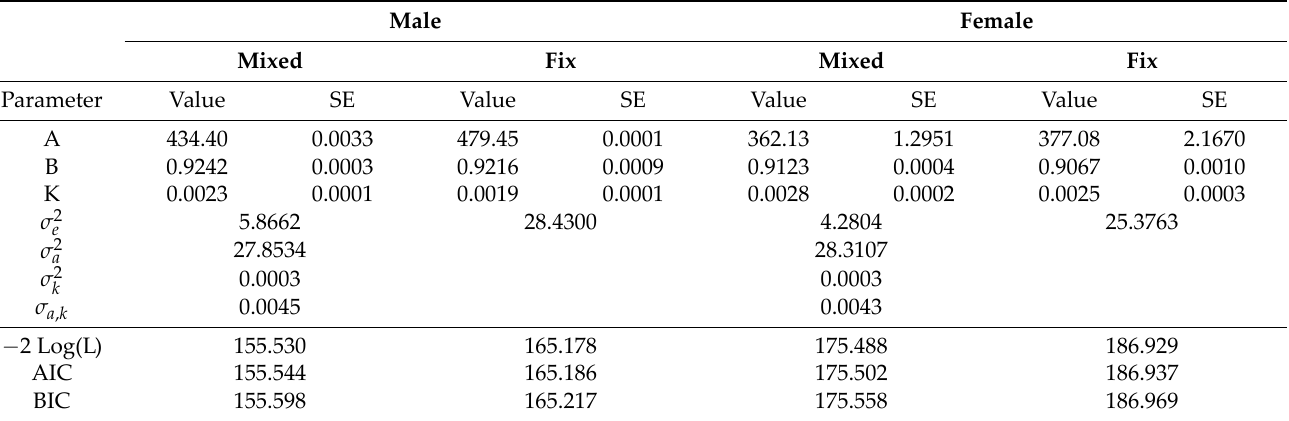
Table 5. Estimates of asymptotic weight (A), constant of integration (B), maturation rate (K), esti‑ mates of residual variance components ( σ 2 e ), of the asymptotic weight ( σ 2 a ), maturation rate ( σ 2 and covariance between asymptotic weight and maturation rate ( σ a , k ), logarithm of the likelihood function ( − 2 Log (L)), Akaike information criterion (AIC) and Schwarz Bayesian information (BIC) for models that used the Brody function in context of mixed and fixed models and by gender. Male